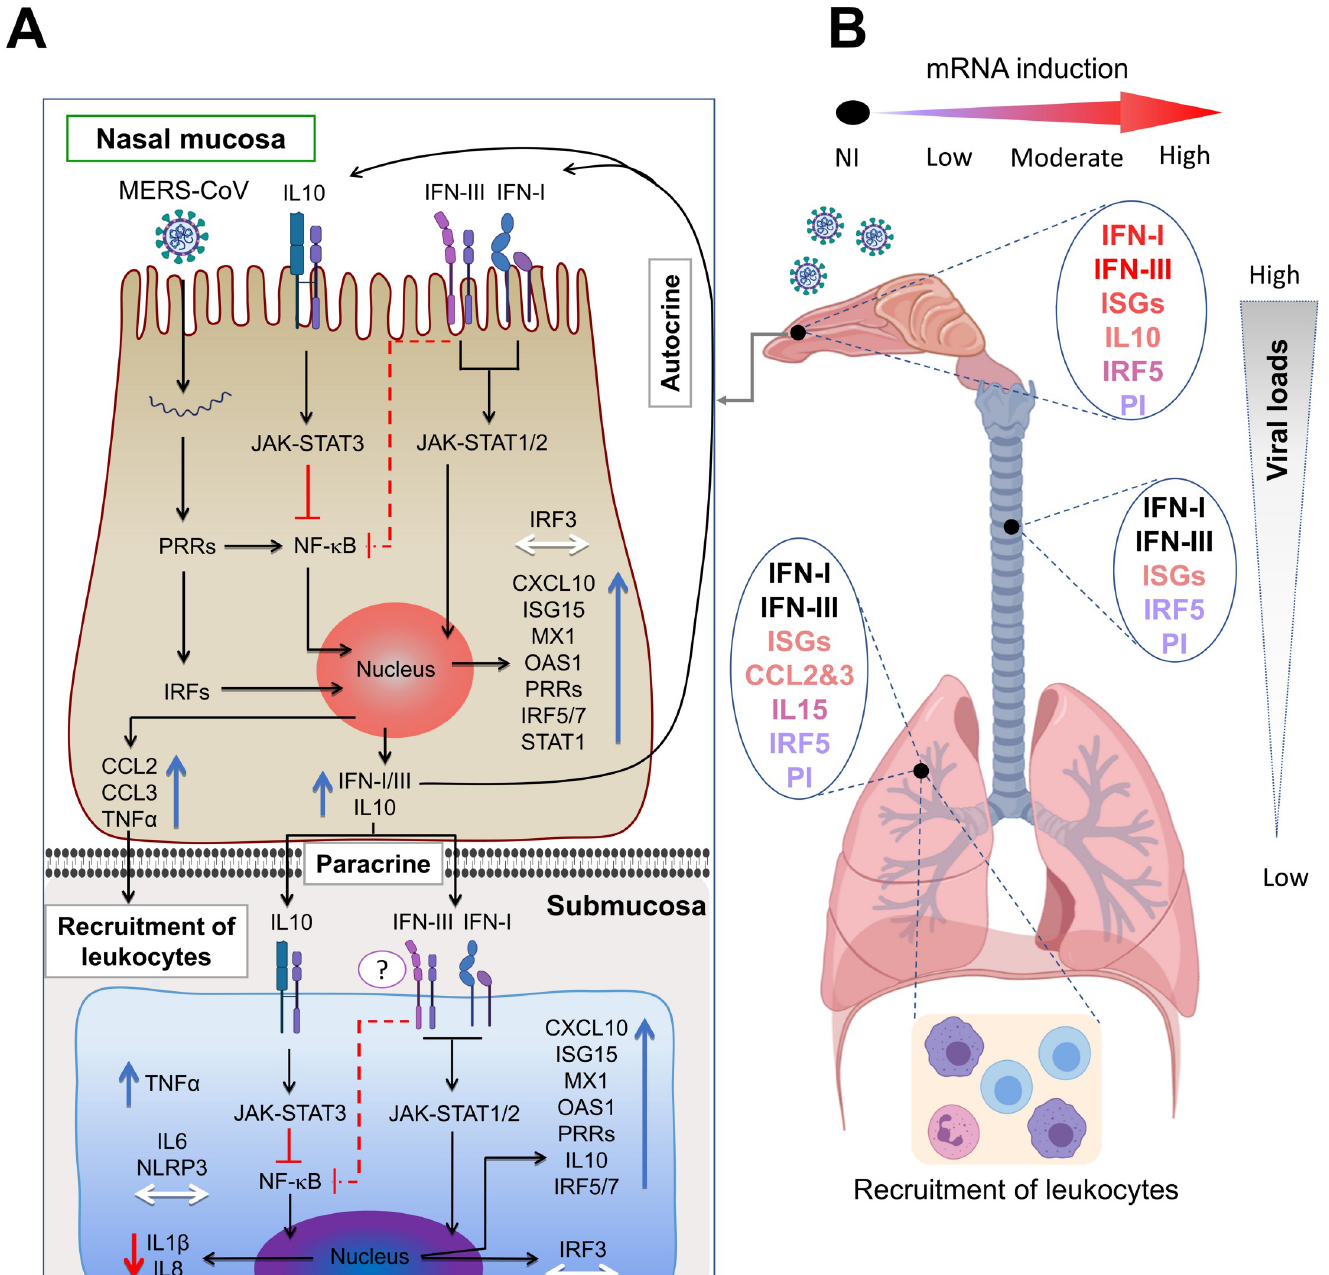
Fig 8. Tentative mechanistic model for MERS-CoV-induced protective innate immune responses in alpaca respiratory tracts. (A) Upon MERS-CoV infection of nasal epithelial cells, PRRs and IRFs are engaged to induce IFNs and ISGs exerting their effects in an autocrine or paracrine manner. Upregulation of IL10 combined with the action of type III IFNs will result in a dimmed synthesis of proinflammatory cytokines under NF- κ B control. Induced chemokines lead to focal, mild infiltration of leukocytes. The paracrine effect of IFNs is evidenced in the nasal submucosa where ISGs are upregulated without endogenous induction of IFNs. IL10 and type III IFNs will act on the NF- κ B pathway preventing production of IL8 and IL1 β mRNAs depriving the NLRP3 inflammasome of its substrate. Slight increased levels of IRF5 mRNAs will indicate the presence of few M1 macrophages in the submucosa. Blue, red and white arrows indicate upregulation, downregulation and unaltered gene transcription respectively. (B) Concomitant to decreased viral loads, transcription of ISGs is lowered in trachea and lungs where IFNs are not induced. Infiltration of mainly mononuclear leukocytes occurs in the lungs as a result of chemokine synthesis in the absence of IRF5 induction but upregulation of IL15. Thus, reduced number of M1 macrophages and activation of NK cells will contribute to a controlled inflammation and clearance of the virus. PI, Pro-inflammatory cytokines; NI, not induced.